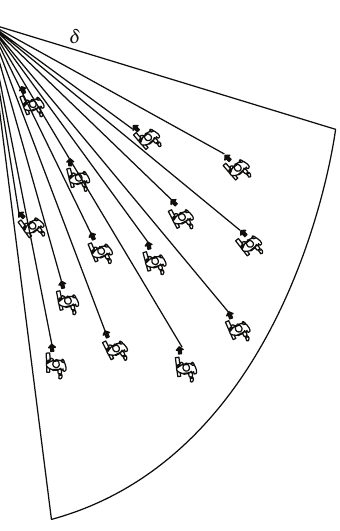
Figure 3: Conformity emergence